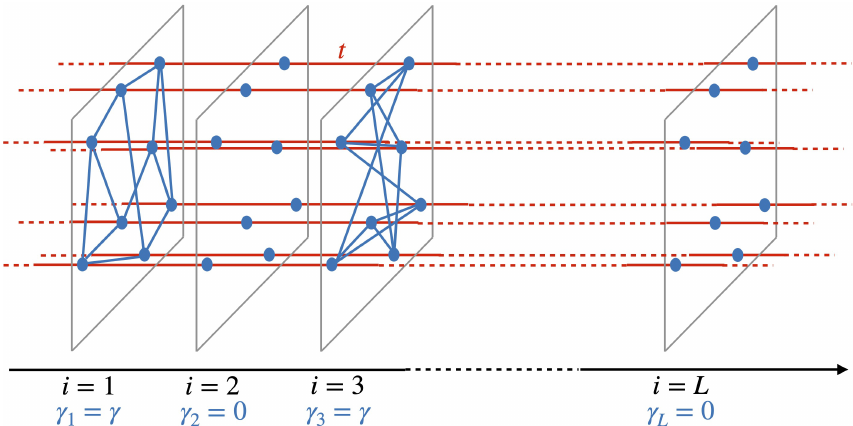
Figure 2: Cartoon of the Anderson or AAH model coupled to random GOE baths with prob- ability 1 − p . The full model is made of M identical copies of a 1 d chain coupled along the x -direction via the inter-layer hopping rates t (red edges), with potential h (equal on all i sites of the transverse planes). The matrix elements between two sites at a given position i along the x direction correspond to the adjacency matrix of a random realization of a RRG (different on each layer) times the intra-layer hopping rate γ (blue edges). The absence of i = 0 with probability p . In the figure the connectivity some RRGs illustrates the fact that γ i of the RRGs is c =